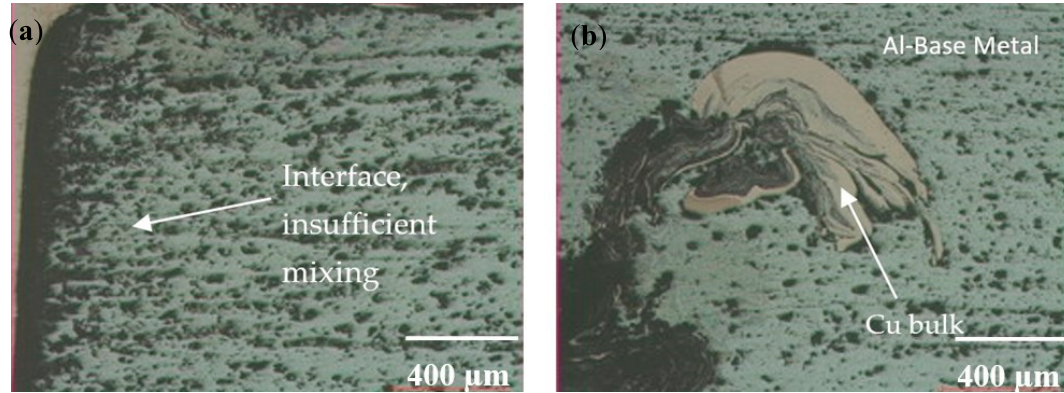
Figure 15. Microstructures of base materials: ( a ) Al ‐ 1050; ( b ) Cu.